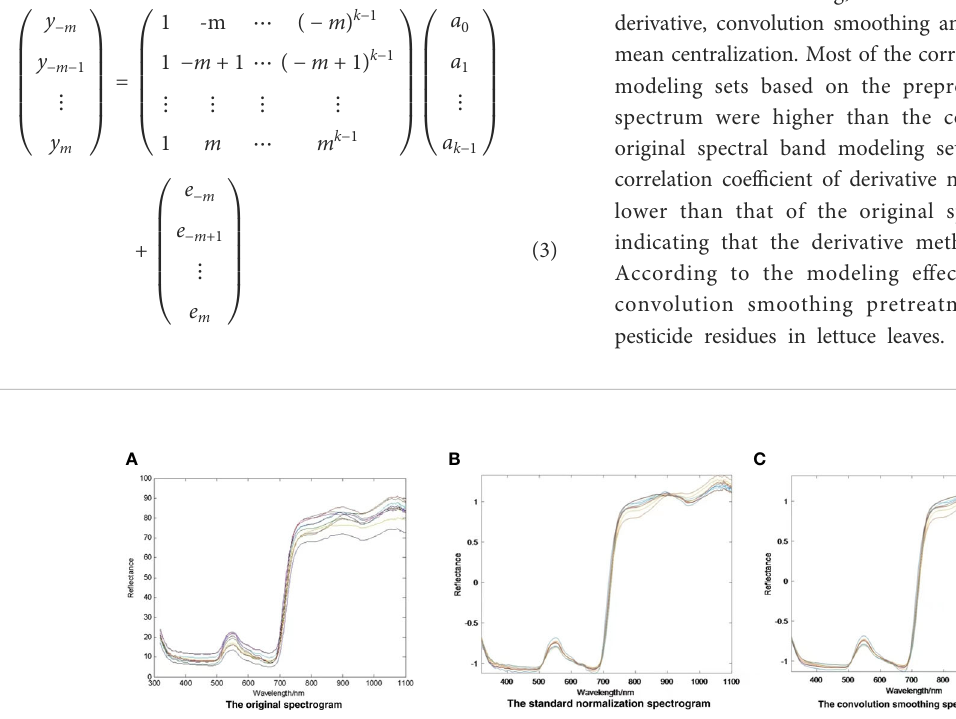
FIGURE 2 Data processing of spectral re fl ectance. (A) The original spectrogram. (B) The standard normalization spectrogram. (C) The convolution smoothing